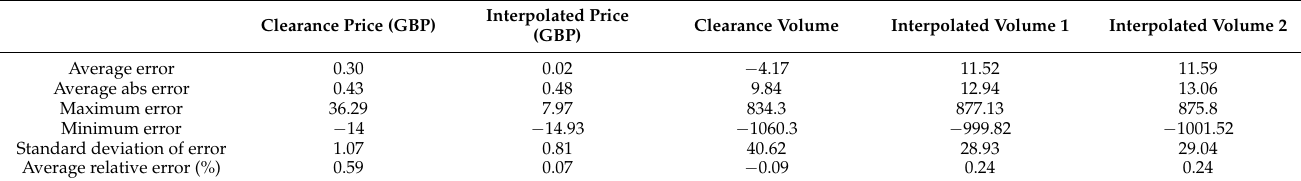
Table A1. Some statistics on the errors for the two interpolation methods for April 2018 to August 2019.